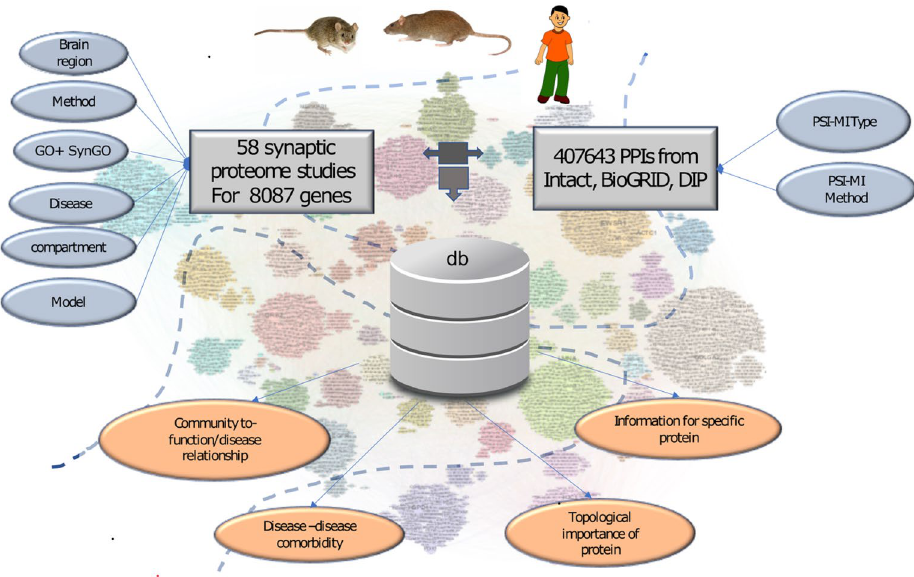
Figure 2. Structure of the SQLite database, which includes 58 synaptic studies covering 8087 unique genes and 407,643 direct protein interactions. Grey ovals on the top show the annotated metadata: left—for nodes/ genes, which include brain region, subcellular compartment, method of extraction, disease and GO function annotation and link to published quantitative models; right—for edges/PPIs, which include PSI-MI type and method. The orange ovals in the bottom illustrate the possible outcomes of the database, including: (1) information for specific protein/gene, and (2) information that could be obtained from PPI network, e.g., protein’s topological importance, community to disease relationship, and disease-disease comorbidity. The database is available as a Supplementary File and from Edinburgh DataShare https:// doi. org/ 10. 7488/ ds/